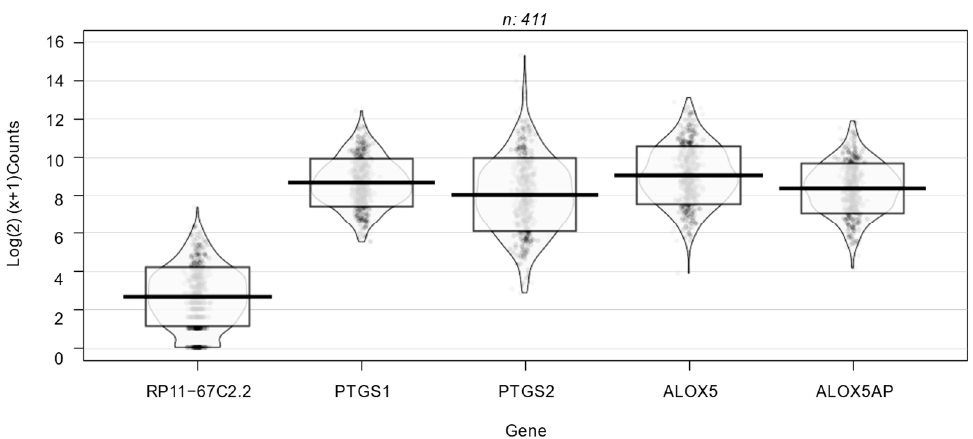
Figure 1. Violin density plots of the genetic expression of COX1, COX2, ALOX5 and ALOX5AP in invasive colorectal cancer. Means and standard deviations are indicated by horizontal bars and box plots, respectively. Prostaglandin Synthetase-1, PTSG1 (Cyclooxygenase-1, COX1). Prostaglandin Synthetase-2, PTSG2 (Cyclooxygenase-2, COX2). Arachidonate 5-Lipoxygenase (ALOX5). Arachi- donate 5-Lipoxygenase Activating Protein (ALOX5AP). RP11-67C2.2: Novel Natural Antisense Transcript Gene, RP11-67C2.2 nested within the terminal region of the ALOX5 gene on chromosome 10q11.21.